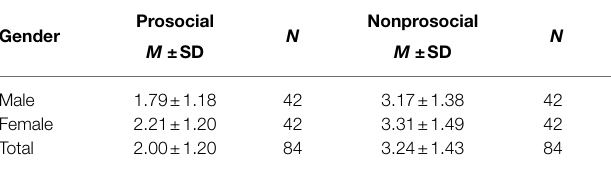
TABLE 2 | Means and standard deviation of post-tested aggressive motivation.